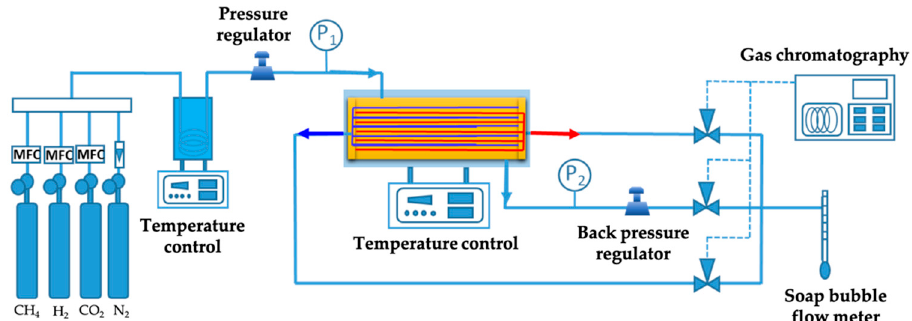
Figure 2. Schematic of the dual membrane separator experimental setup.